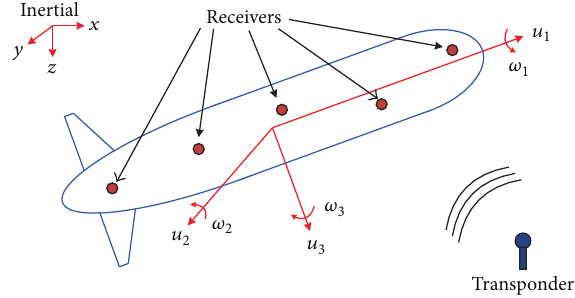
Figure 2: AUV navigation system adopted from